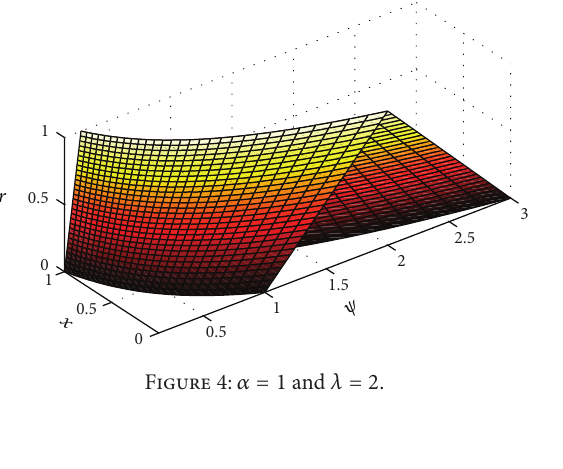
Figure 4: 𝛼 = 1 and 𝜆 = 2 .